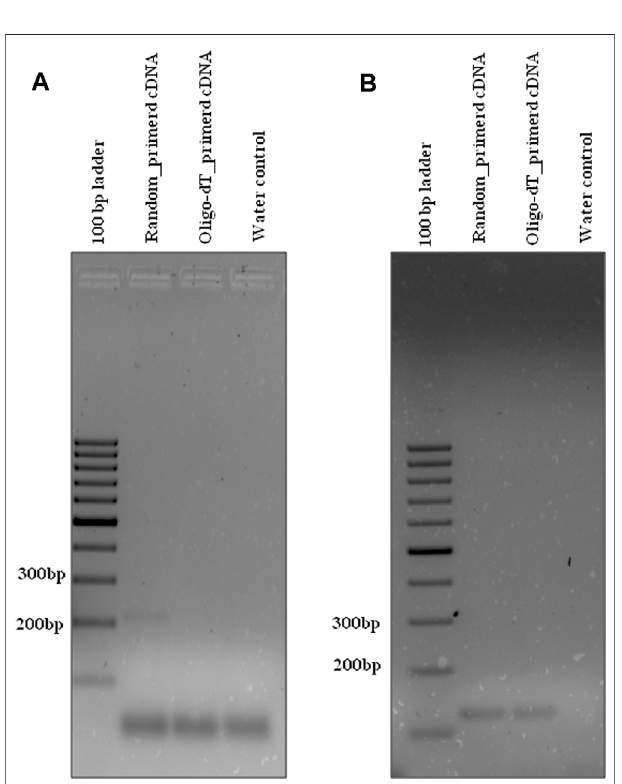
FIGURE 6 | Divergent PCR in HeLa cell lines. Divergent PCR using (A) hl_DC_02 yielded ~267 bp amplicon with random-primed cDNA but not with oligo-dT-derivedcDNA,whereasconvergentPCRusing (B) hl_ β -actinyielded ~292 bp amplicon with both random-primed cDNA and oligo-dT- derived cDNA. Generuler 100 bp ladder was loaded as a